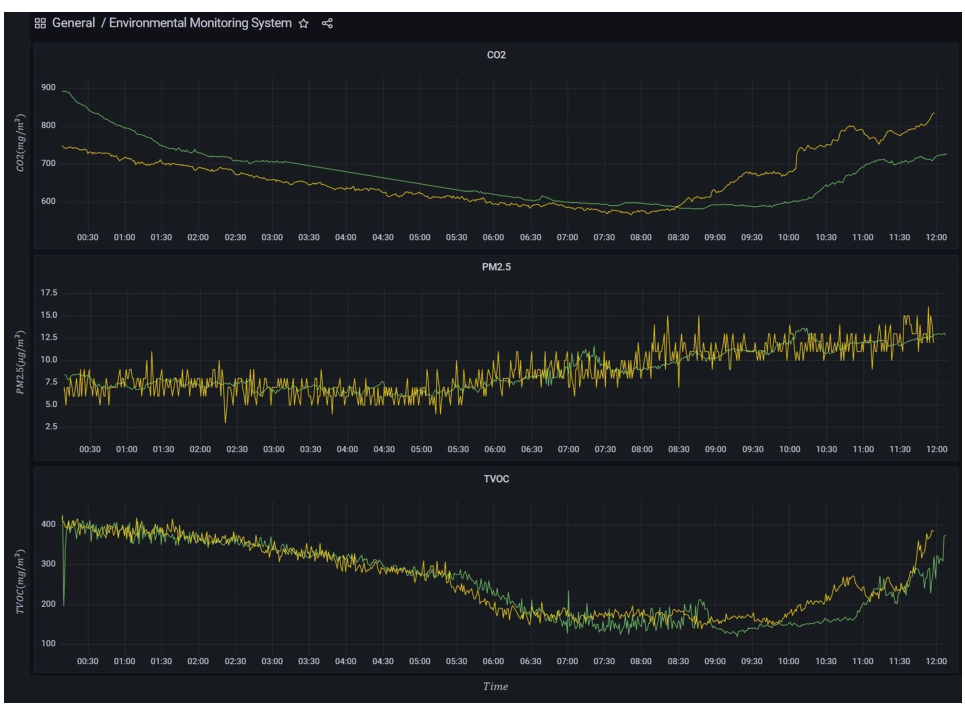
Figure 10. Indoor air quality monitoring system (CO 2 , PM2.5, and TVOC). Green line: predicted data; yellow line: actual